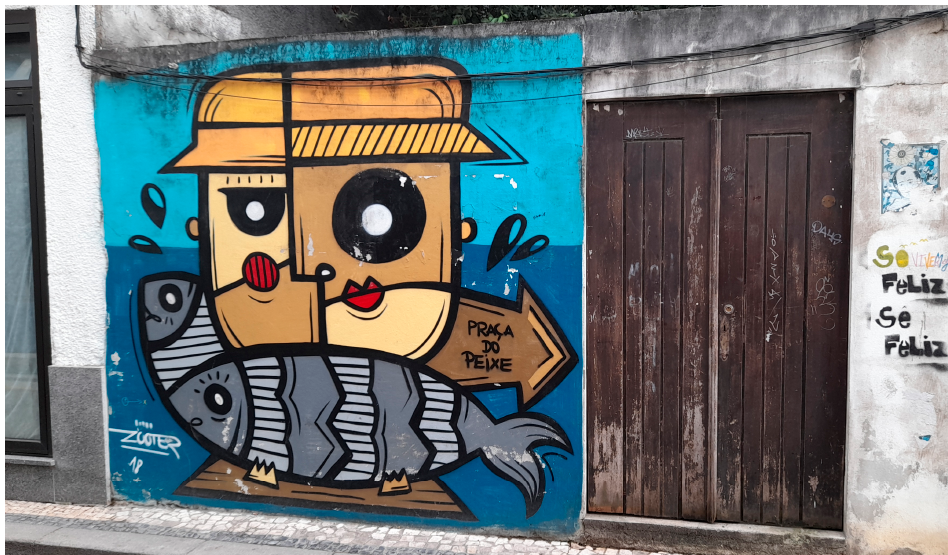
Figure 8. Aveiro’s identitary elements, by Fábio Carneiro, 2021 (Source: author’s own photos, 2022).